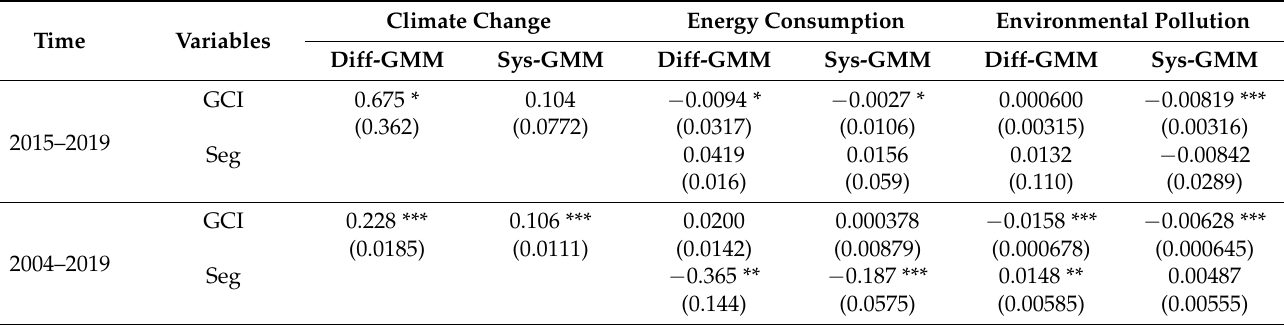
Table 9. Time heterogeneity analysis (OECD).